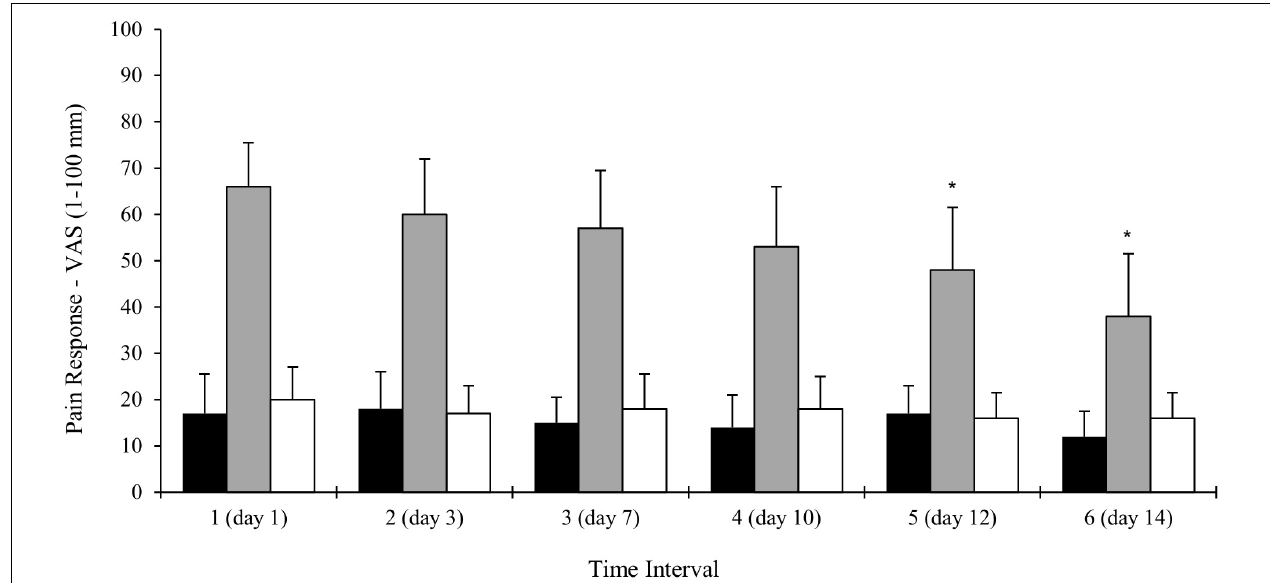
FIGURE 5 | Changes in LL-BFR participant’s self-reported pain before, during and 5 min after the completion of exercise. Data collected over six time points (every five training sessions) during the 3-weeks intervention. Data is expressed as mean ± SD, ∗ p < 0.05. VAS, visual analog